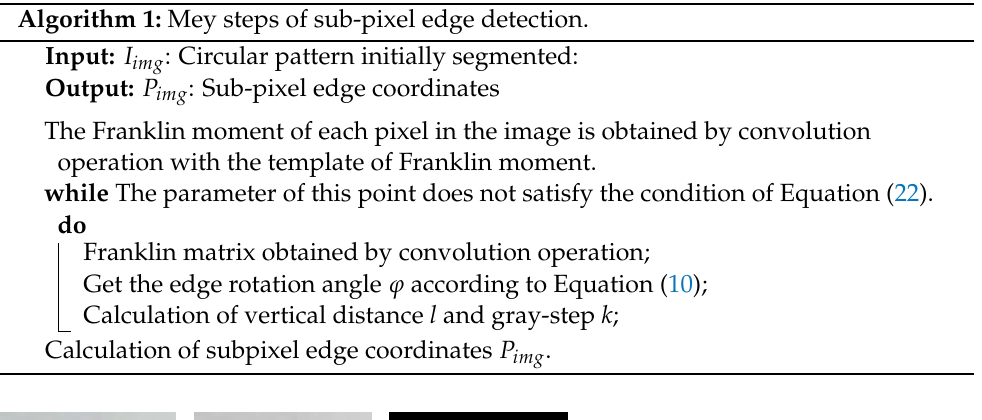
Algorithm 1: Mey steps of sub-pixel edge detection.